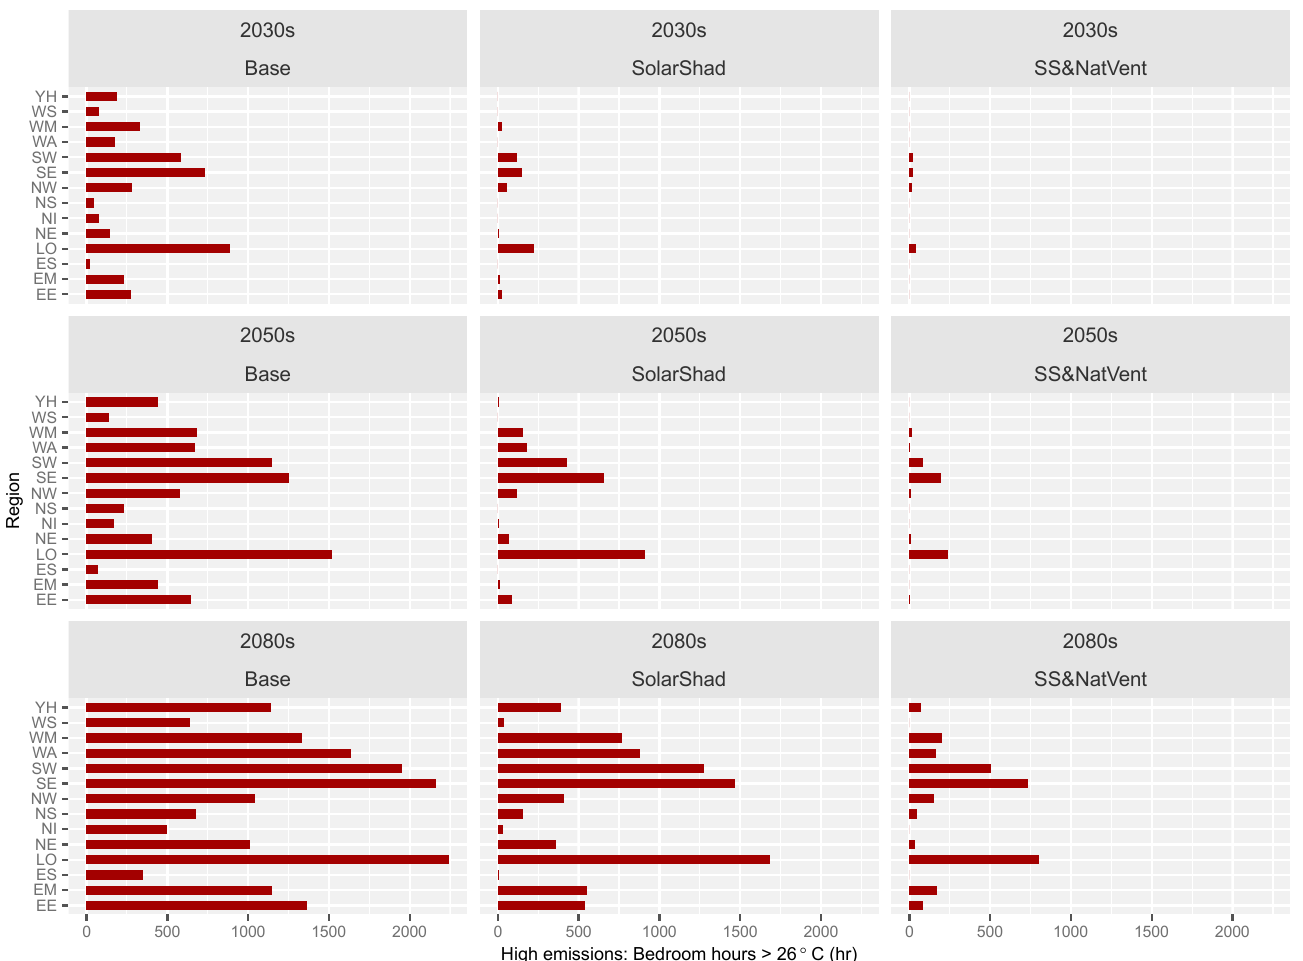
Figure 12. Results for high-emission scenario in different decades: for base case, with solar shading (SolarShad), and solar shading combined with ventilation (SS&NatVent).